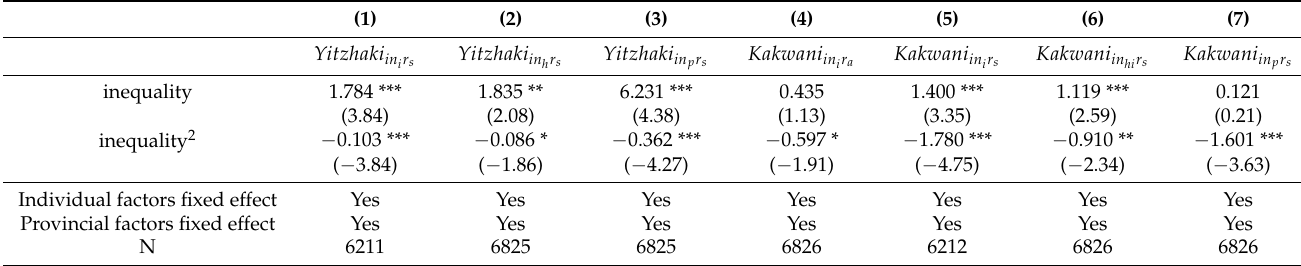
Table 4. The effect of individual-level income inequality on subjective environmental pollution: robustness test based on different measurements of income inequality at in individual level.